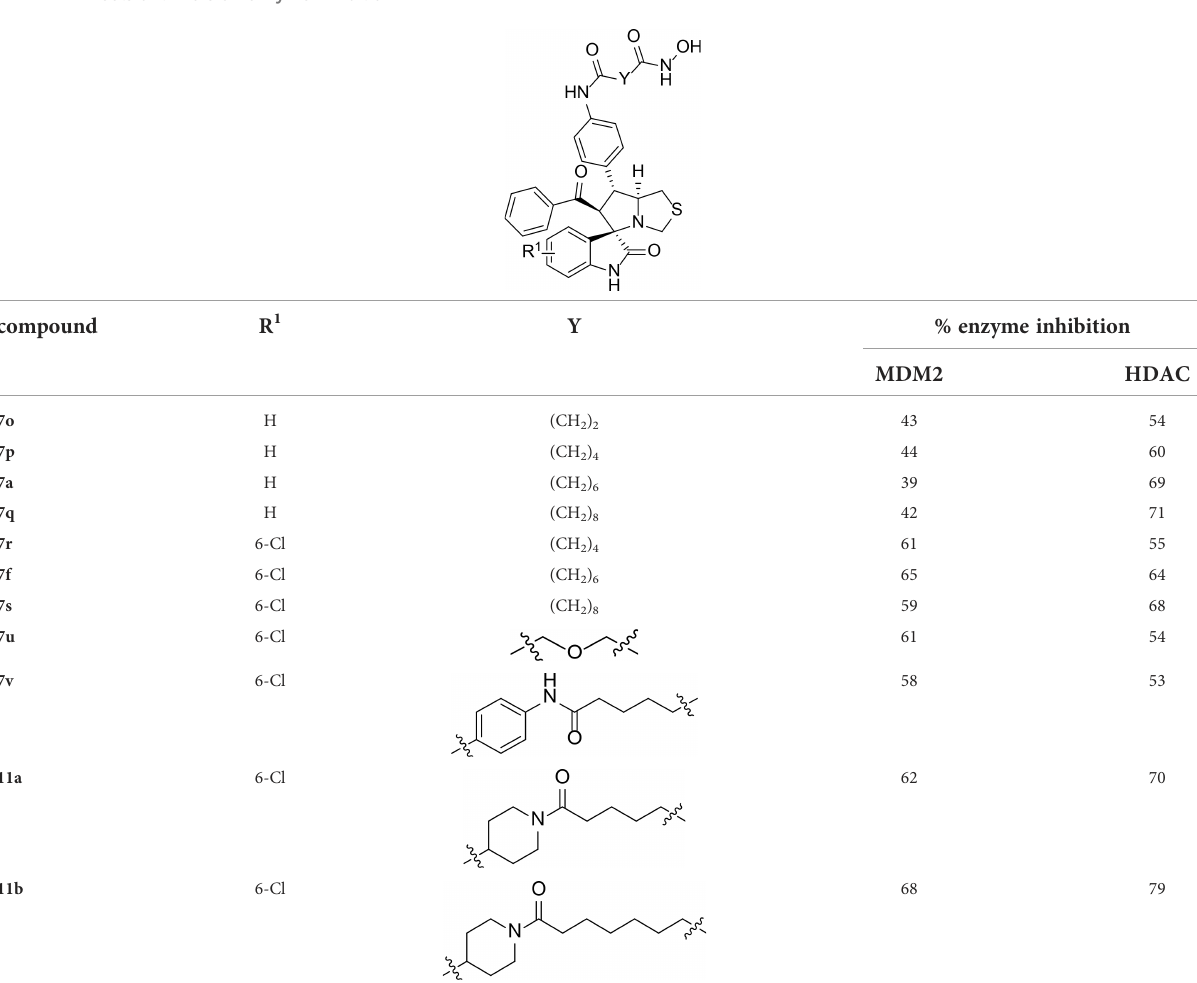
TABLE 4 Effects of linkers on enzyme inhibition.